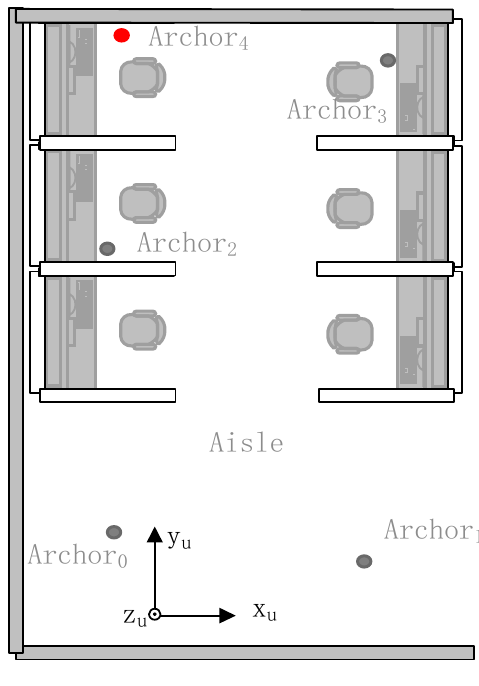
Figure 5. Experimental site.